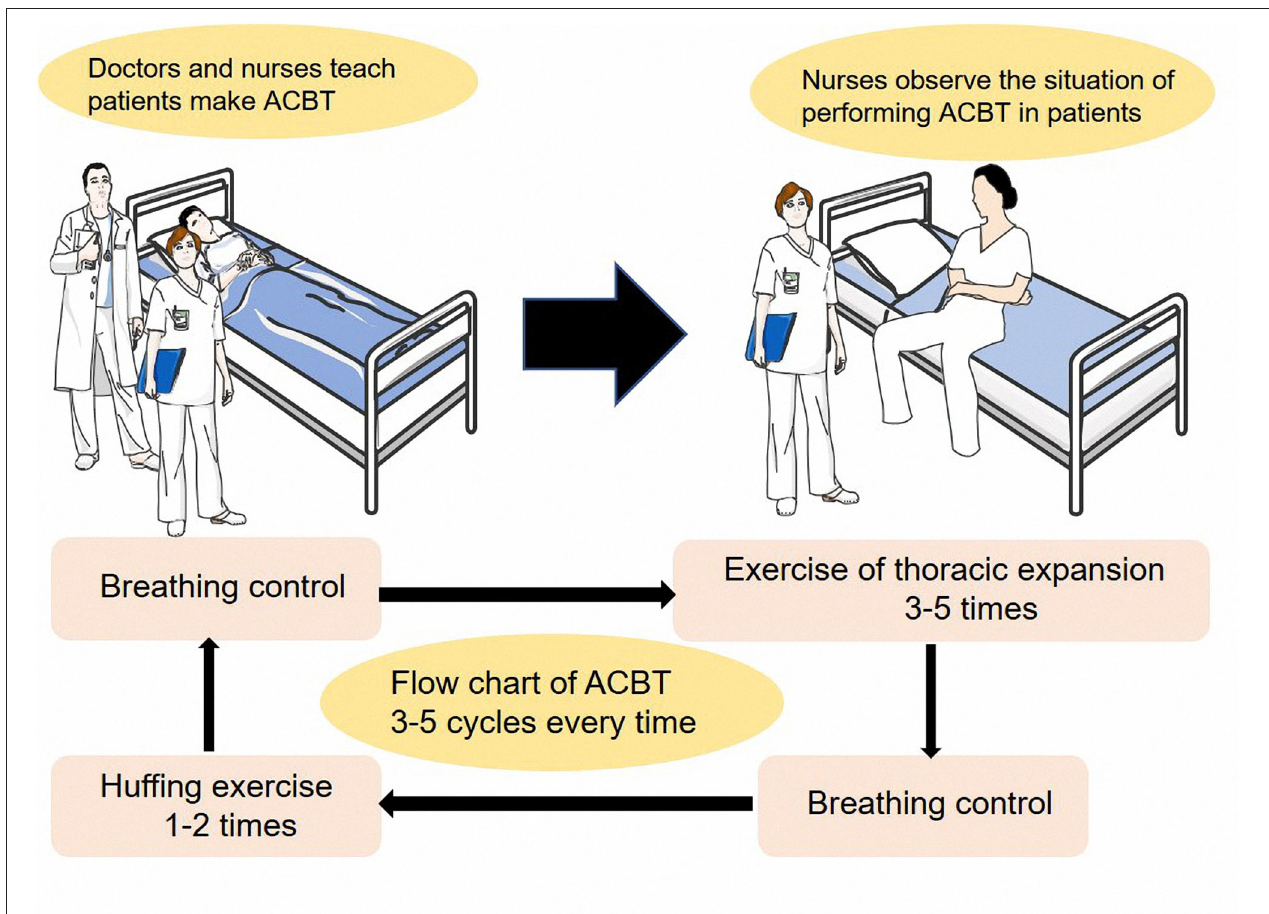
FIGURE 2 | The sketch map of